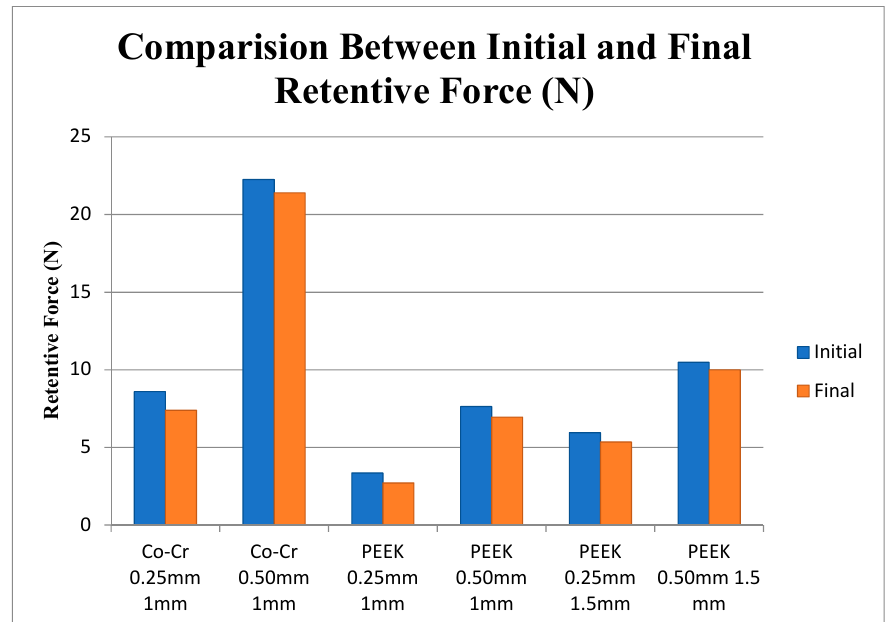
Polymers 2023 , 15 , x FOR PEER REVIEW Figure 8 . Comparison between initial and final retentive force (N). Figure 8. Comparison between initial and final retentive force (N).